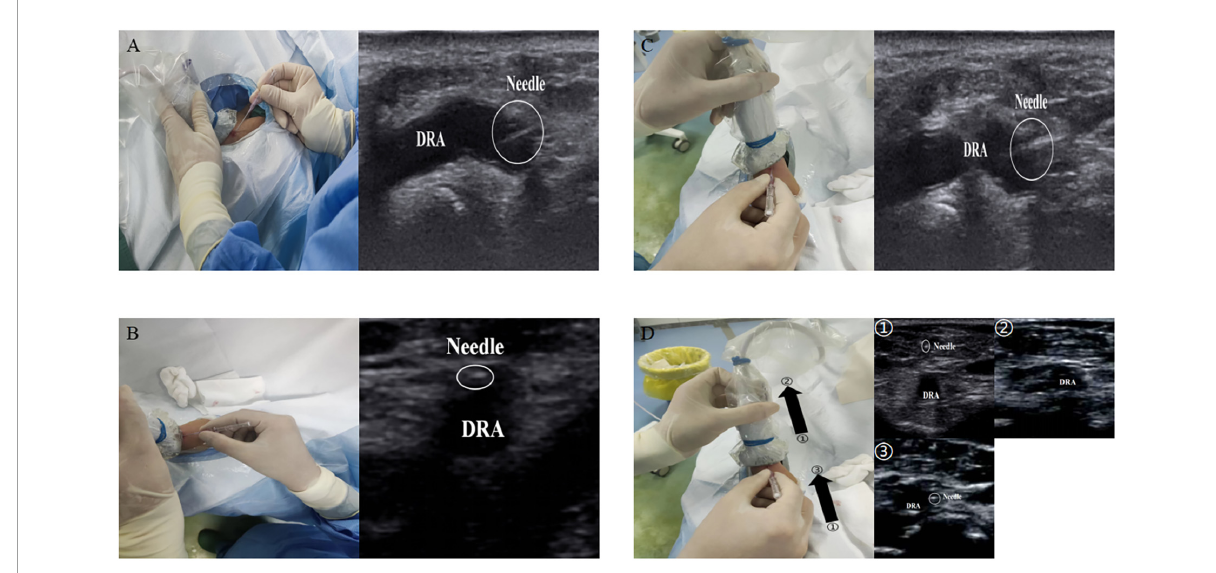
FIGURE3 Ultrasound guided puncture. (A) The long-axis in-plane method; (B) the short-axis out-of-plane method; (C) the oblique axis in-plane method; (D) the dynamic needle tip positioning. (cid:192) , seeing the highlighted needle tip; (cid:193) , holding the puncture needle still and translating the probe proximally until the tip disappears; (cid:194) , followed by holding the ultrasound probe still and advancing the puncture needle until the tip reappears in the center of the